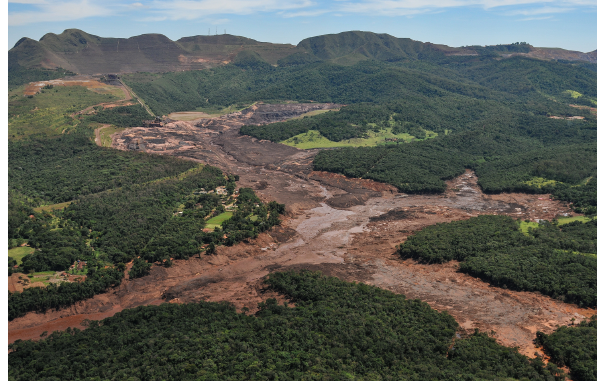
Figure 6. Assumed outflow breach hydrograph developed for the Brumadinho tailings dams failure in January